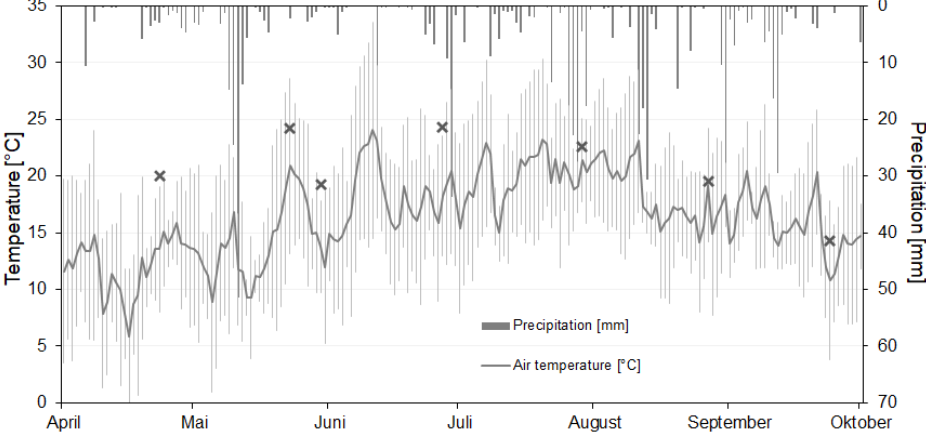
Figure 1. Average air temperature (°C) including the range (light grey bars) and precipitation data (mm) from April to September 2014 measured at weather station Gleisdorf by Zentralanstalt für Meterologie und Geodynamik (ZAMG). Bold crosses indicate measured soil temperature (°C) at Kaindorf on sampling dates.